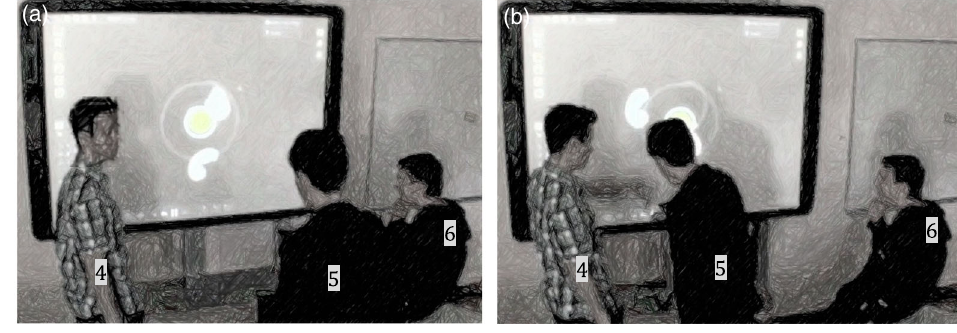
FIG. 12. After the throw, student 5 responded by proposing his own idea of how to observe the outcome of this experiment that would, as he believed, support his own argument that a planet would return after a long time. He knew that the simulation speed could be adjusted and suggested that they increase its speed to avoid waiting a long time before the planet would supposedly